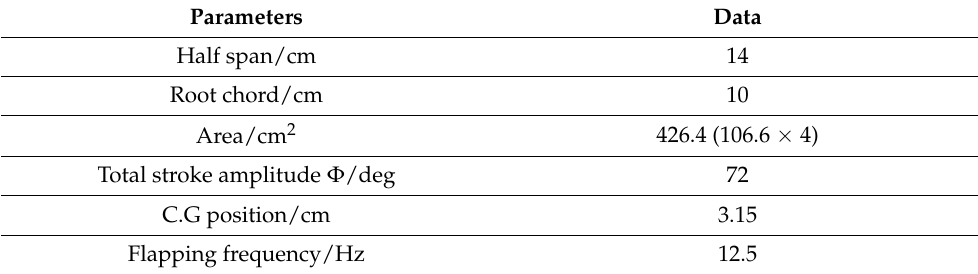
Figure 3. Coordinate system and parameters defined. Table 1. Flapping wings parameters.